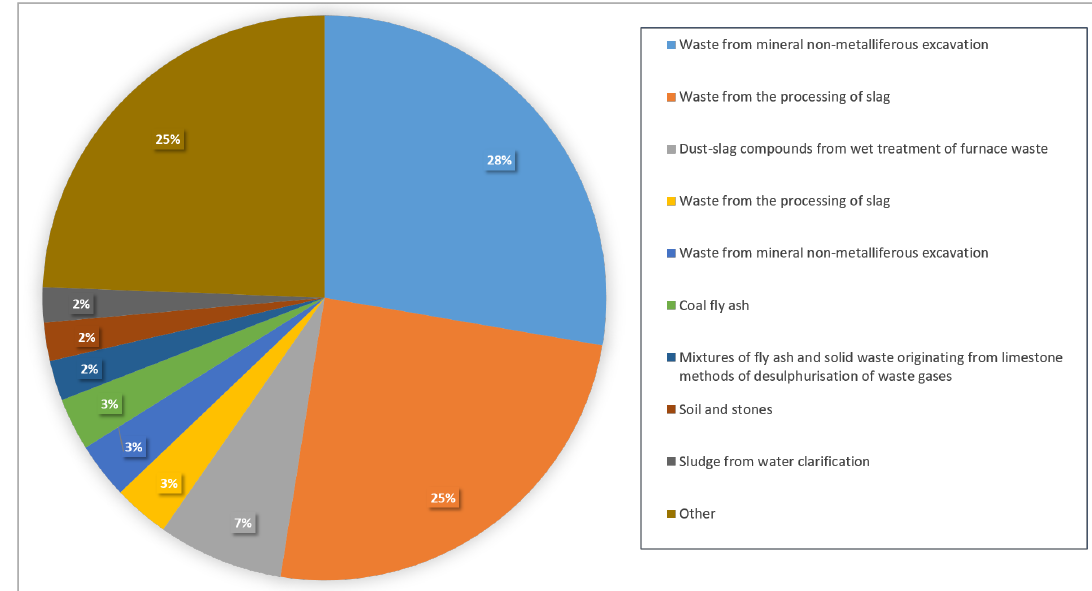
Figure 1. Structure of waste generated in Poland in 2017, by waste type and excluding municipal waste. Data source: Statistics Poland